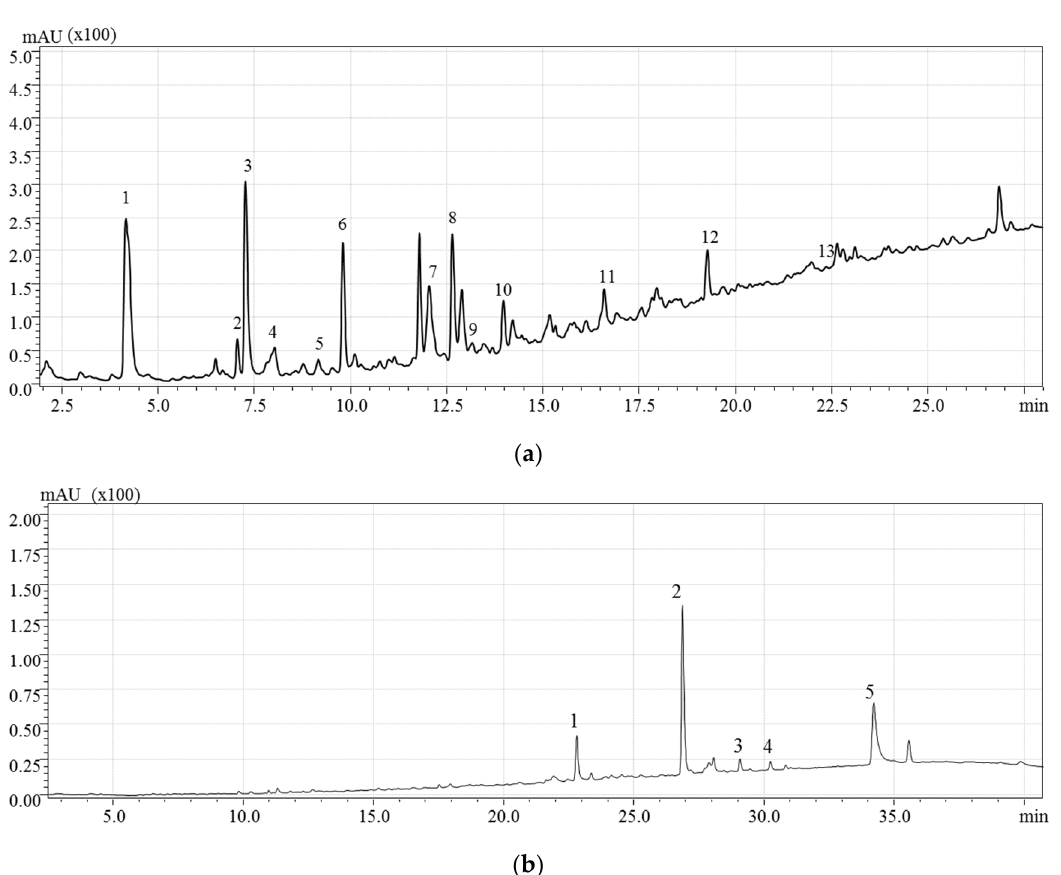
Figure 6. HPLC-PDA chromatogram of hazelnut skin phenolic compounds extract. ( a ) Compounds detected at 280 nm: 1, gallic acid; 2, protocatechuic acid; 3, procyanidin trimer C2; 4, prodelphinidin beta-type dimer; 5, prodelphinidin beta-type dimer; 6, prodelphinidin beta-type dimer; 7, procyanidin beta 1 dimer; 8, (+) catechin; 9, procyanidin beta-type trimer; 10, procianidin beta-type trimer; 11 (−) epicatechin; 12, procyanidin beta-type dimer gallate; 13, epicatechin 3- O -gallate. ( b ) Compounds detected at 360 nm: 1, myricetin rhamnoside; 2, quercetin-3- O -rhamnoside; 3, ploretin-2- O -glucoside; 4, kampferol rhamnoside; 5, quercetin.